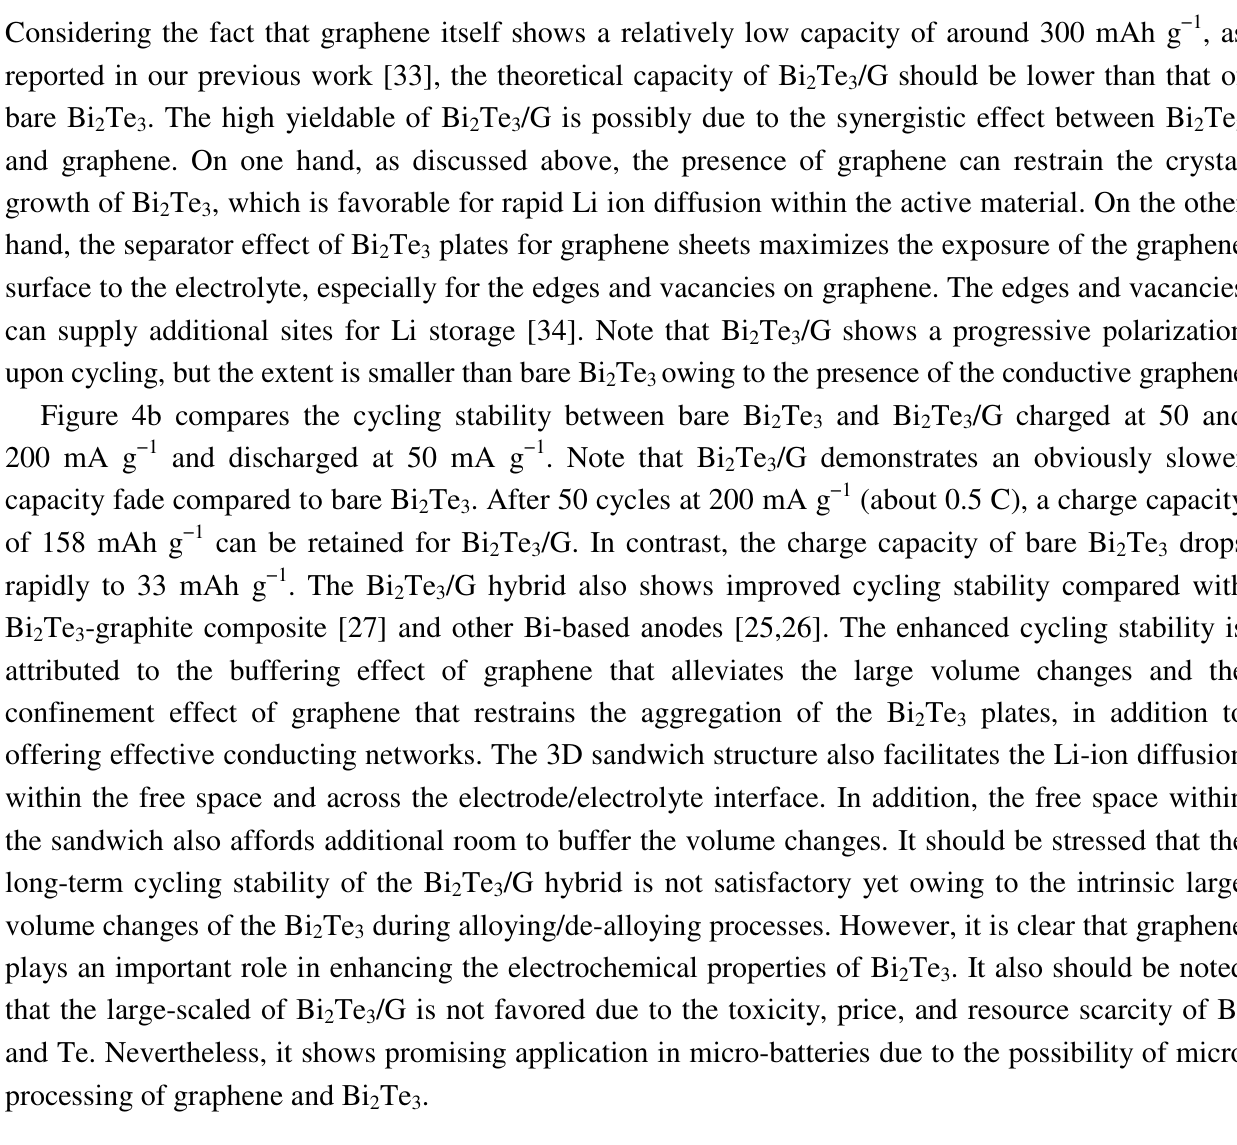
Figure 4. ( a ) Voltage profiles; and ( b ) cycling stability of Bi